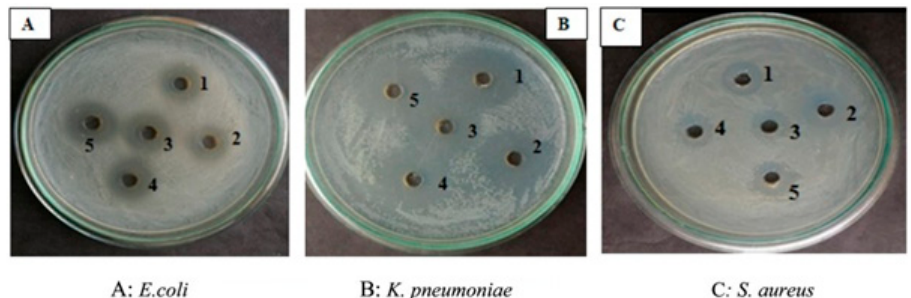
Figure 2. Antibacterial activity of extracted lipopeptide. ( A ): Escherichia coli ; ( B ): Klebsiella pneumoniae ; ( C ): Staphylococcus aureus . Here, 1 to 5 are different concentrations of extracted lipopeptide from 10 to 50 µ g/mL (with the permission after [139]).